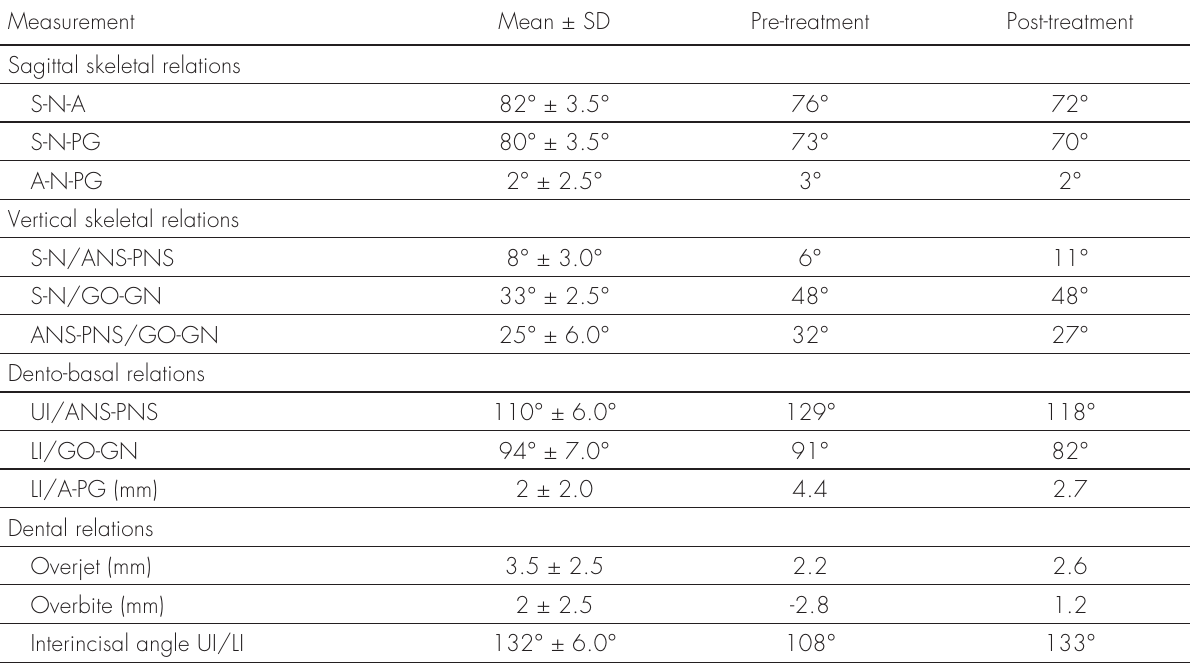
Table I. Pre-treatment and post-treatment cephalometric analysis.